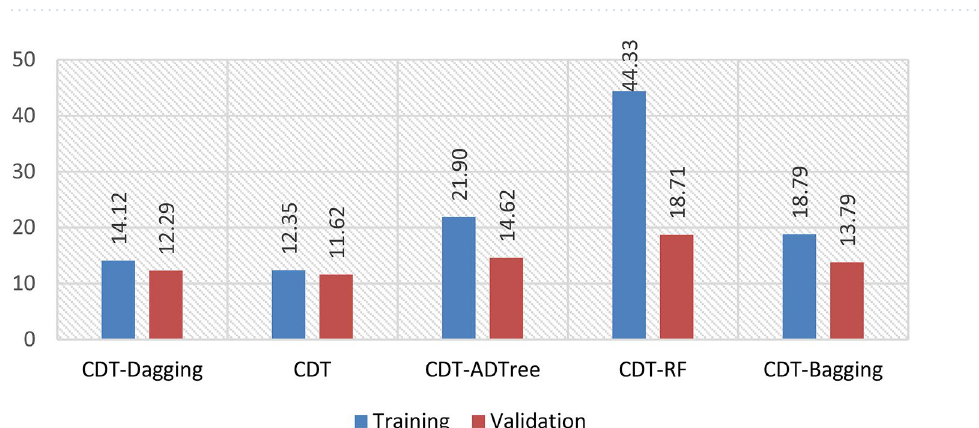
Figure 4. Area under the curve of the models in the training and validation data.